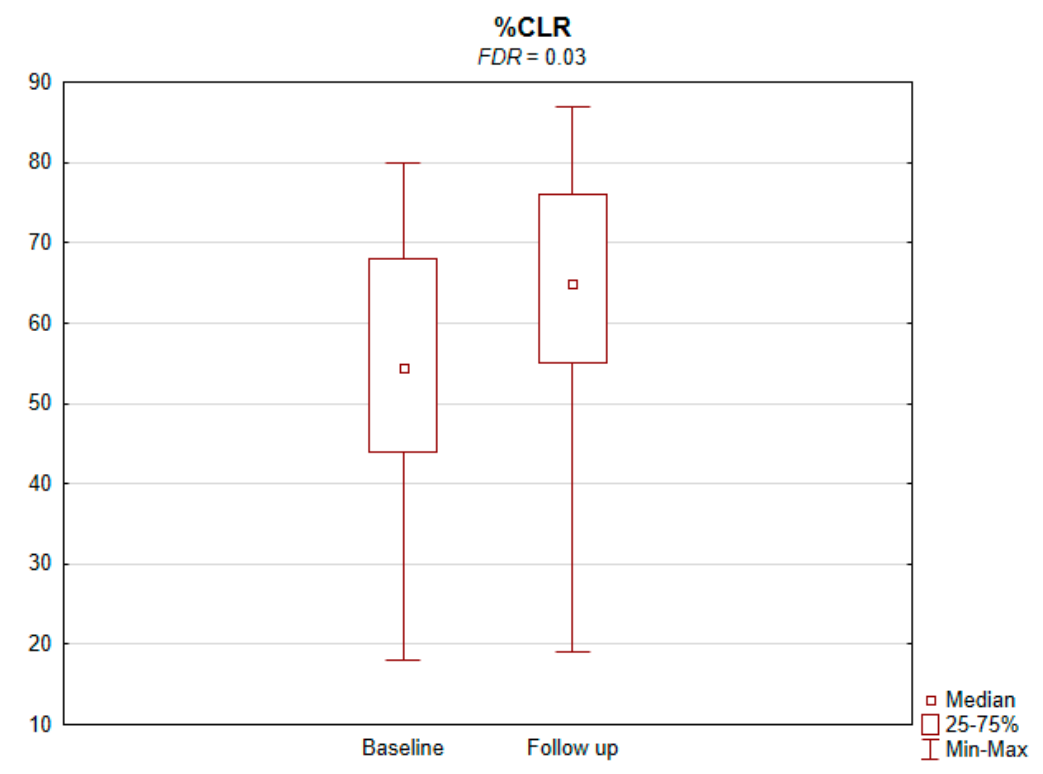
Figure 9. Percentage of conceptual level responses (%CLR) in Wisconsin Card Sorting Test before and after the intervention. FDR —false discovery rate.